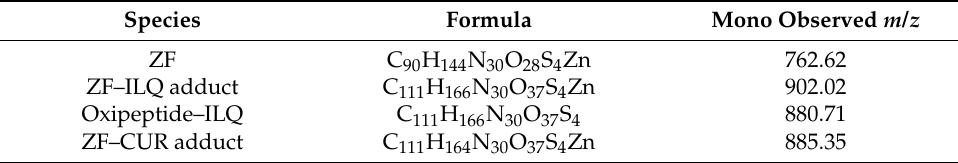
Table 1. Species observed in the ESI-MS spectra (charge